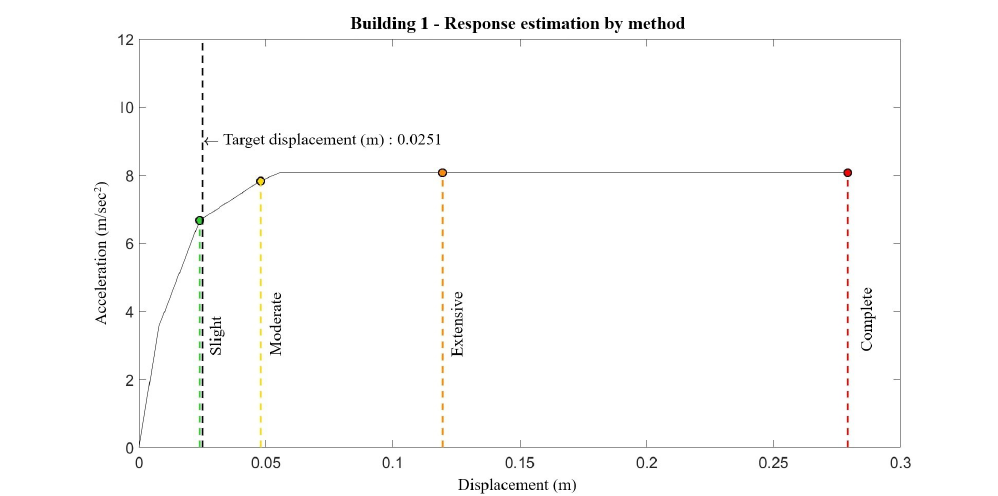
Figure 8. Building 1: Response estimation by means of the SMSA methodology.